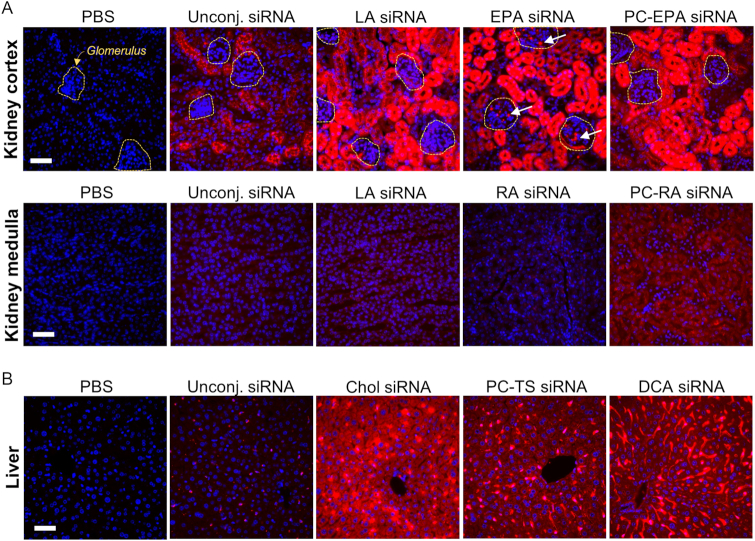
The conjugate impacts the cell-type distribution in kidney and liver. Representative fluorescence images of (A) kidney cortex and kidney medulla or (B) liver sections from mice injected subcutaneously with 20 mg/kg Cy3-labeled lipid-conjugated siRNAs. Nuclei stained with DAPI. Three mice per conjugate were injected and tissue collected 48 h after injection. Images taken at 40 × magnification and collected at the same laser intensity and acquisition time. Scale, 50 μm.